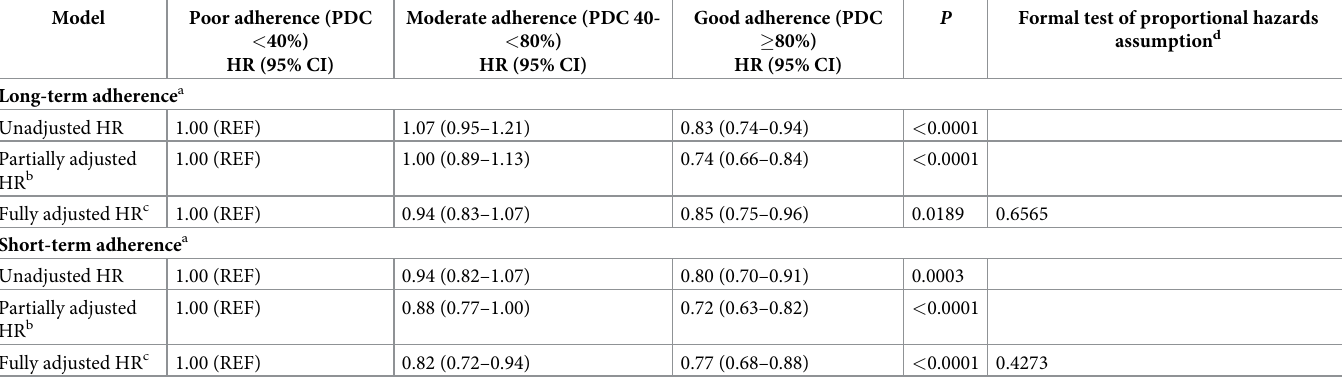
Table 2. Cox proportional hazard models for risk of preventable HF hospitalizations, MarketScan 2008–2012 (N = 26,439).